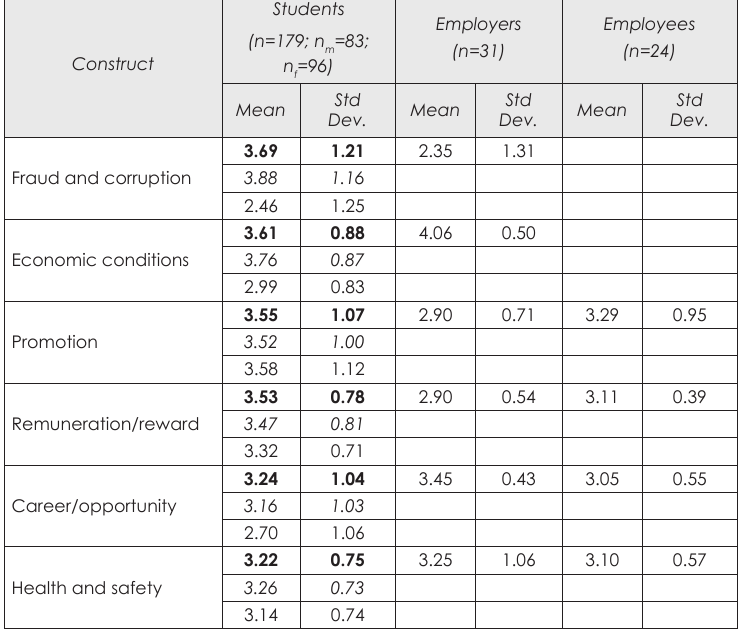
Table 18: Comparative aggregated means of perception constructs